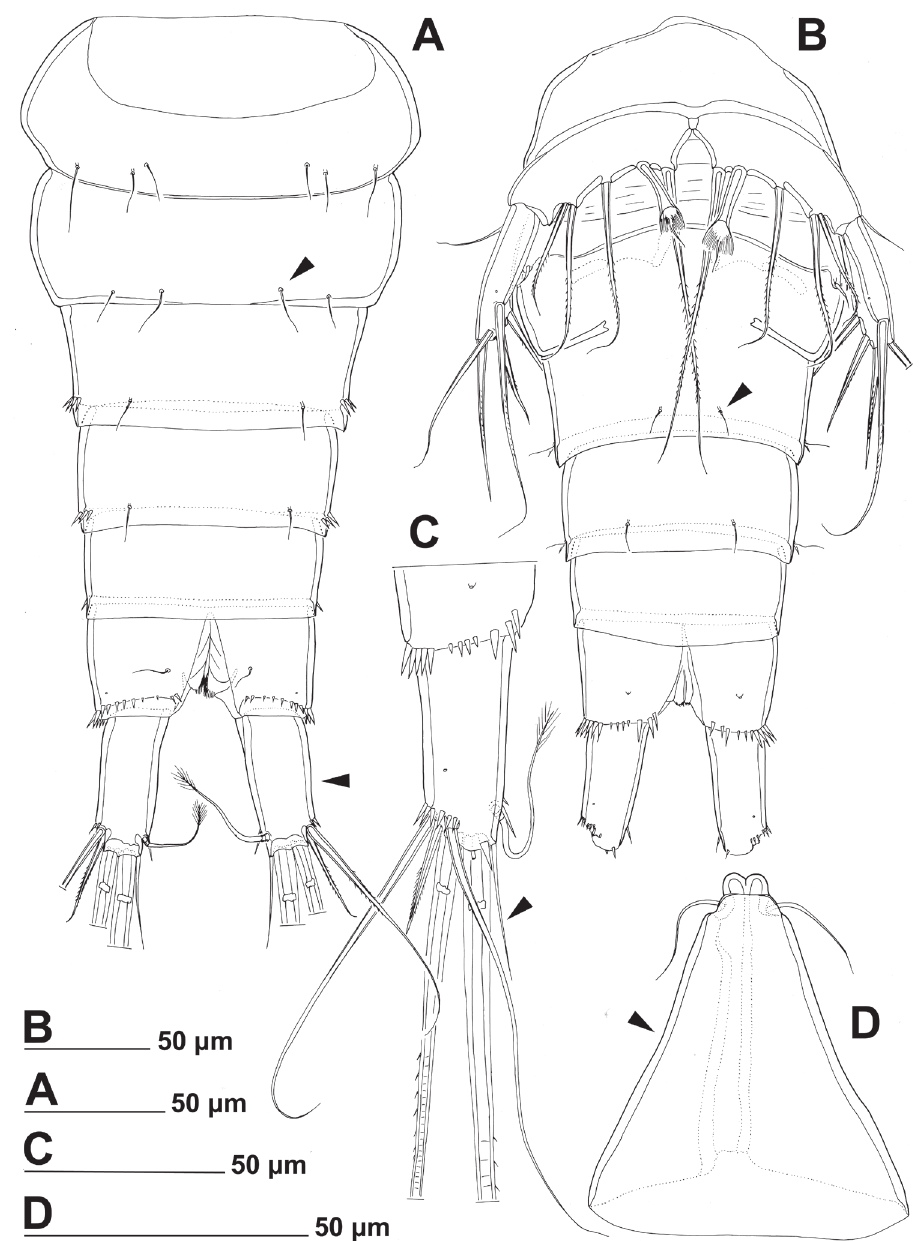
Figure 10. Stenhelia taiae Mu & Huys, 2002, line drawings, female: A urosome, dorsal B urosome, ventral (caudal rami armature omitted) C right caudal ramus, ventral D rostrum, dissected and compressed, dorsal. Arrowheads indicate morphological characters different from those in S. pubescens Chislenko,